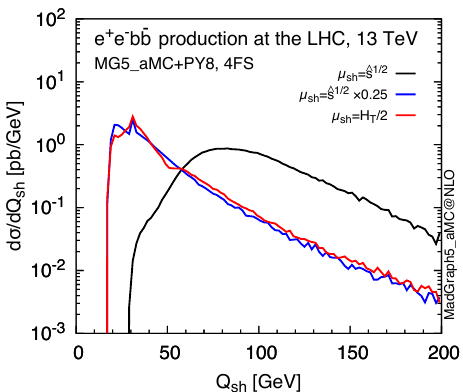
Figure 2 . Probability distributions of the shower scale Q sh (i.e. SCALUP ) in various event samples generated by MG5 aMC